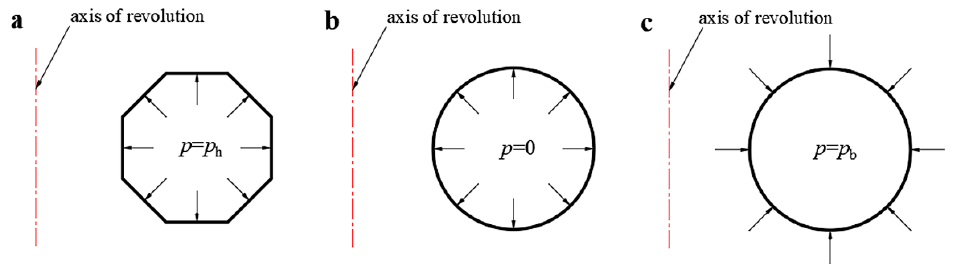
Figure 4. Three loading steps of toroidal pressure hulls: plastic deformation under internal hydro- forming pressure ( p = p h ) ( a ); spring back under zero hydroforming pressure ( p = 0 ) ( b ); external collapse under external hydrostatic pressure ( p = p b ) ( c